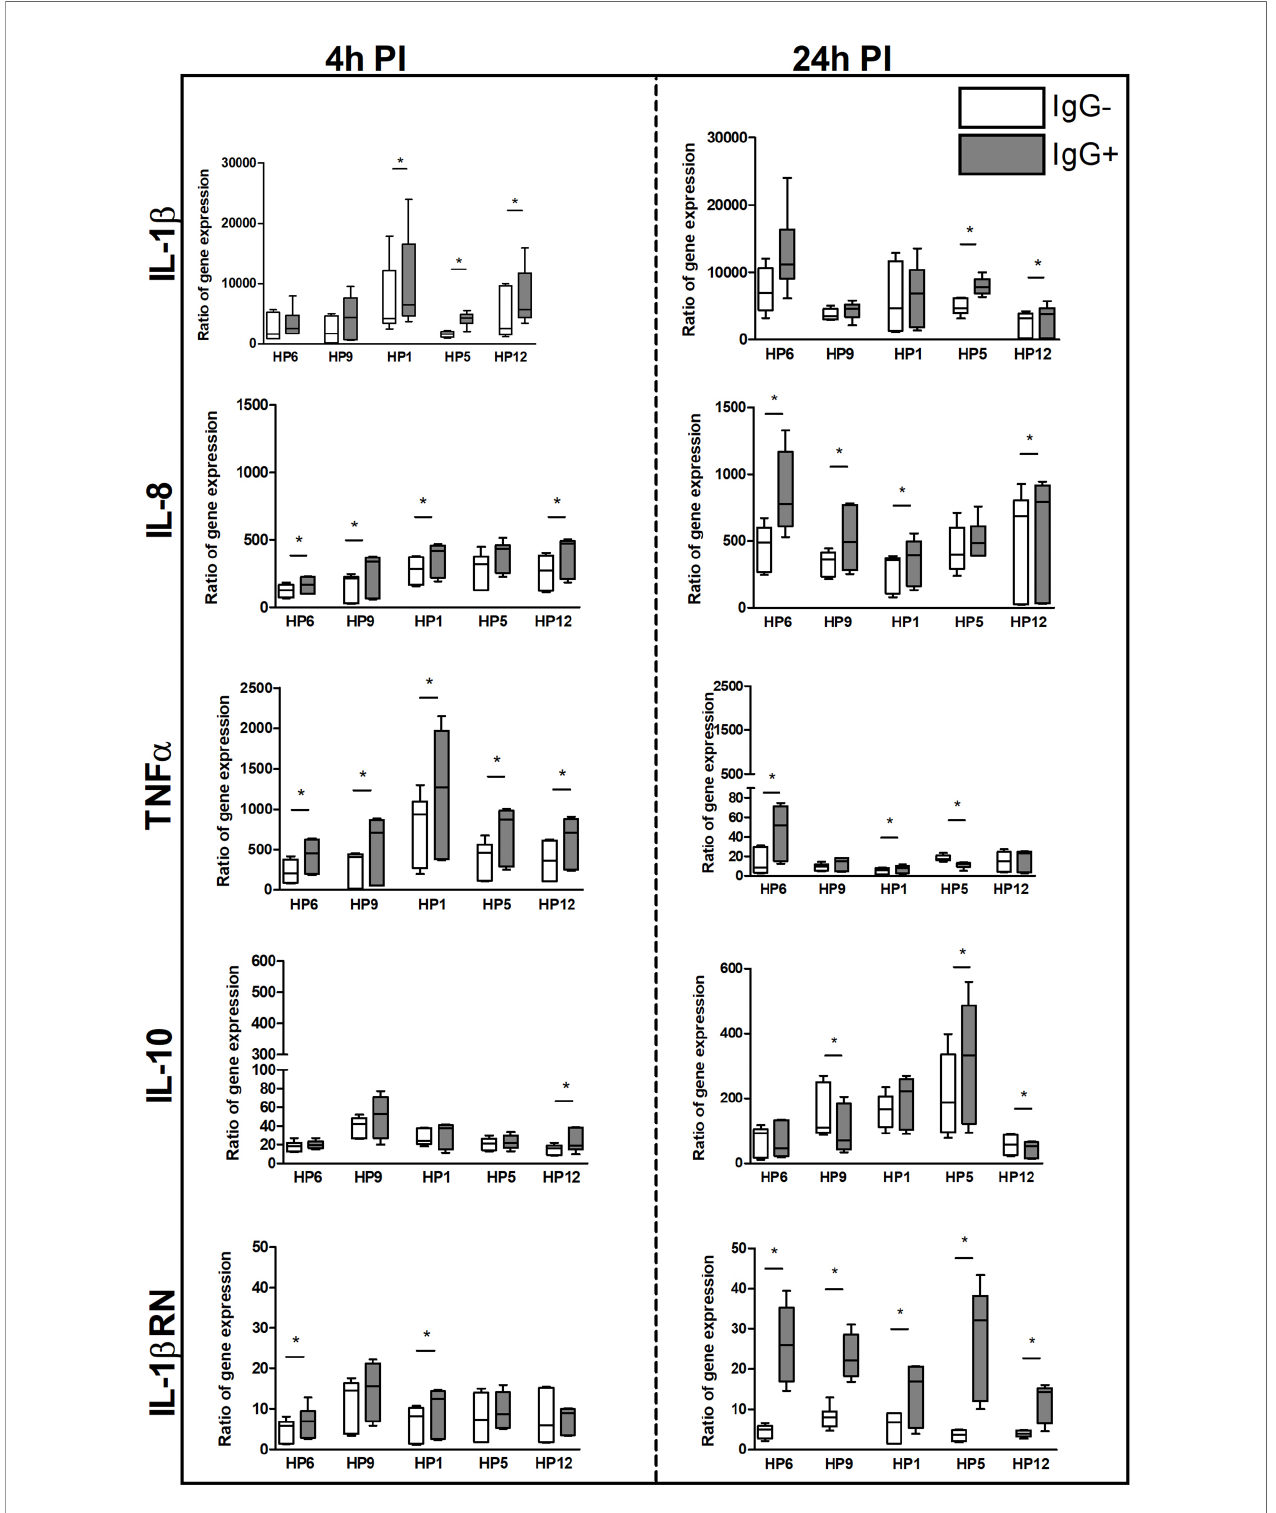
FIGURE 7 | The immune response of PAMs at the transcriptional level. PAMs were infected with various G. parasuis strains for 4 and 24 h. The mRNA expression of IL-1 b , IL-8, TNF- a , IL-10 and IL-1RN was measured by real-time PCR at these PI times. The degree of gene expression was calculated as a fold of the reference gene expression, hypoxanthine phosphoribosyltransferase, and fi nal results are displayed as the ratio of gene expression in the infected sample to expression in the non-infected. Signi fi cant difference between groups with (IgG+) or without (IgG-) the post-vaccinal IgG is denoted by asterisk